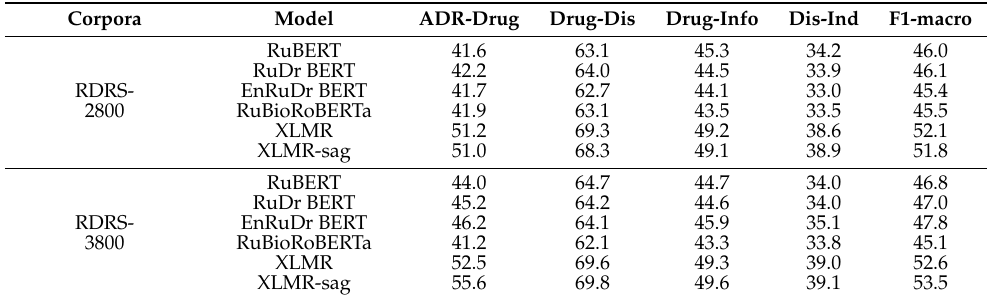
Table 7. Accuracy on the RDRS dataset (joint approach). ADR-Drug—ADR-Drugname, Drug-Dis—